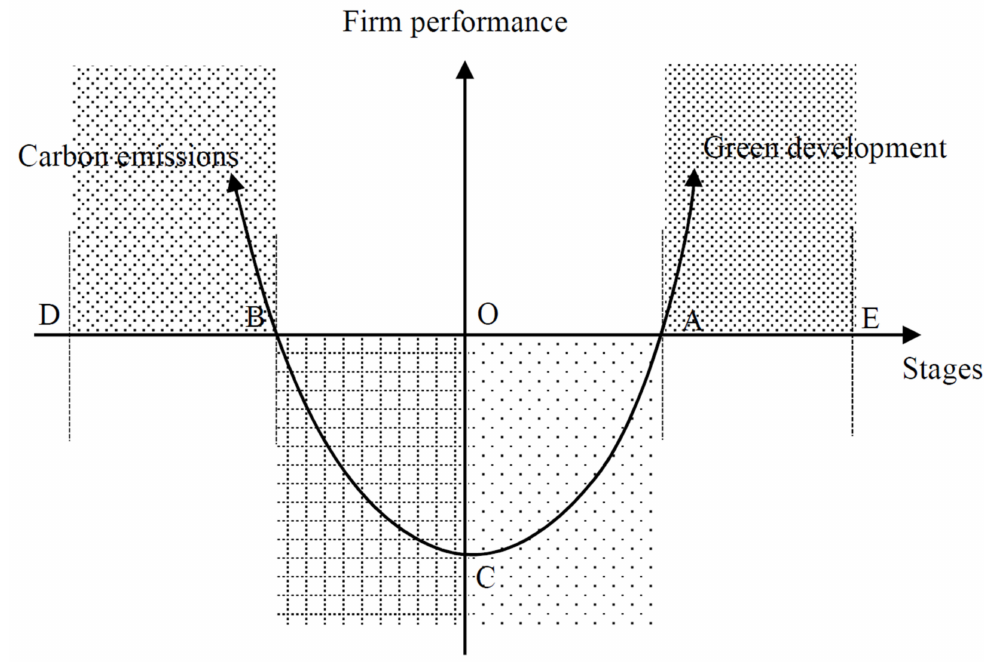
Figure 1. Four development stages of a firm from its startup to the entire green